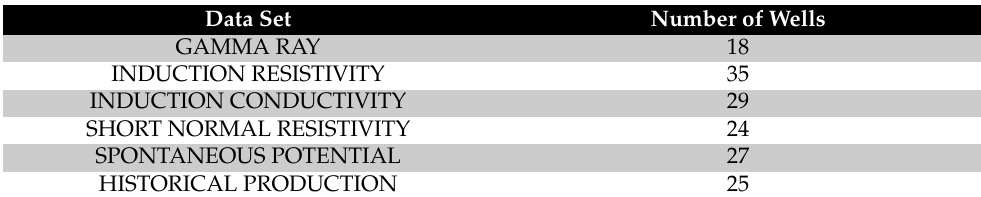
Table 3. Availability of well logs and historical production data.